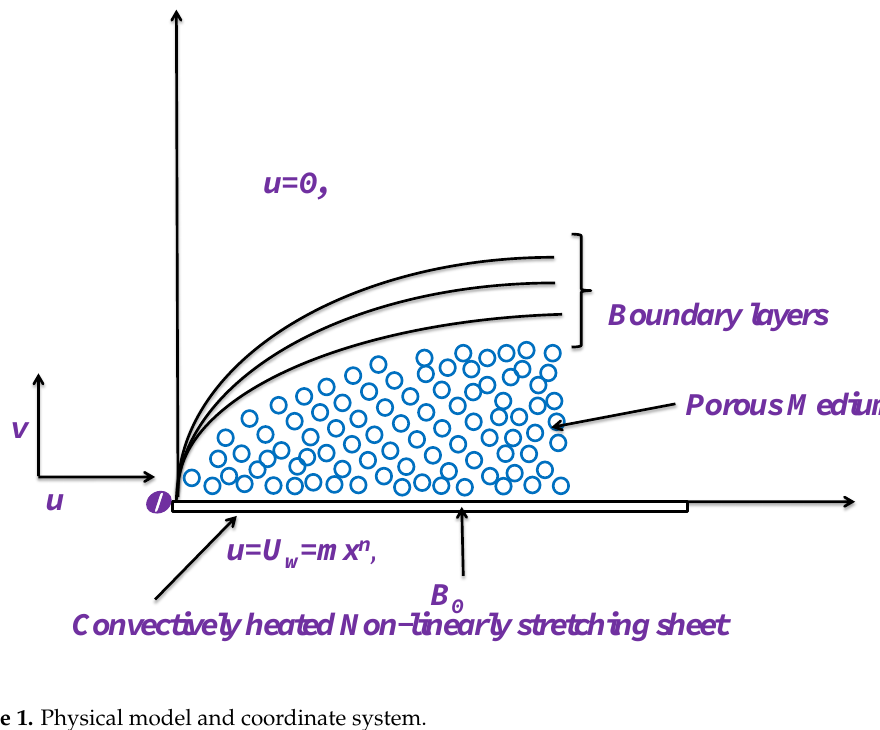
Figure 1. Physical model and coordinate